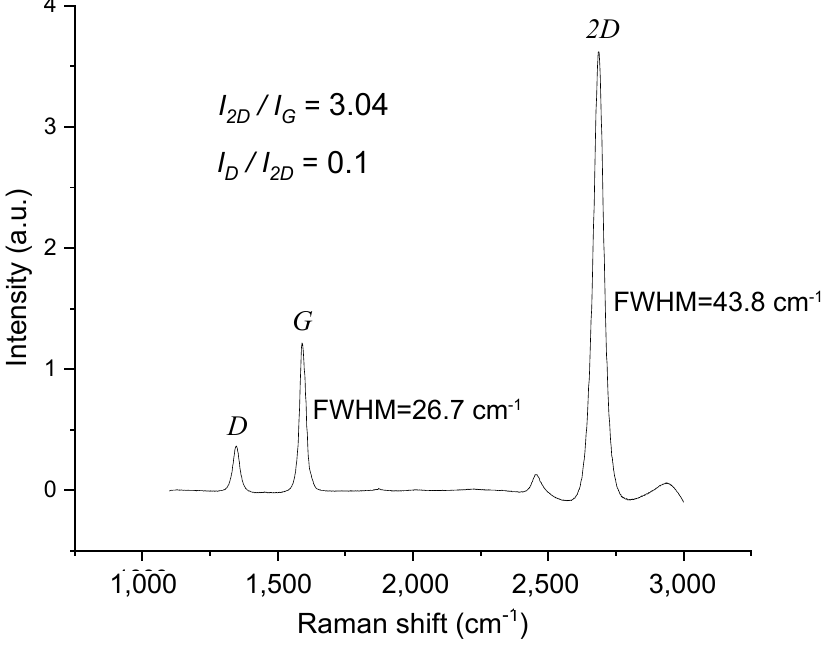
Figure 3. Raman spectrum of transferless CVD graphene on SiO 2 after the removal of the Pt seed layer. The intensity ratio I 2 D / I G = 3 between the 2 D and G peaks at ∼ 2690 cm − 1 and ∼ 1590 cm − 1 is typical for monolayer CVD graphene. The full-width-at-half-maximum (FWHM) of the peaks is FWHM 2 D ≈ 44 cm − 1 and FWHM G ≈ 27 cm − 1